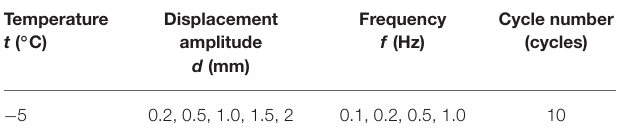
FIGURE 1 | Photo of the viscoelastic damper.